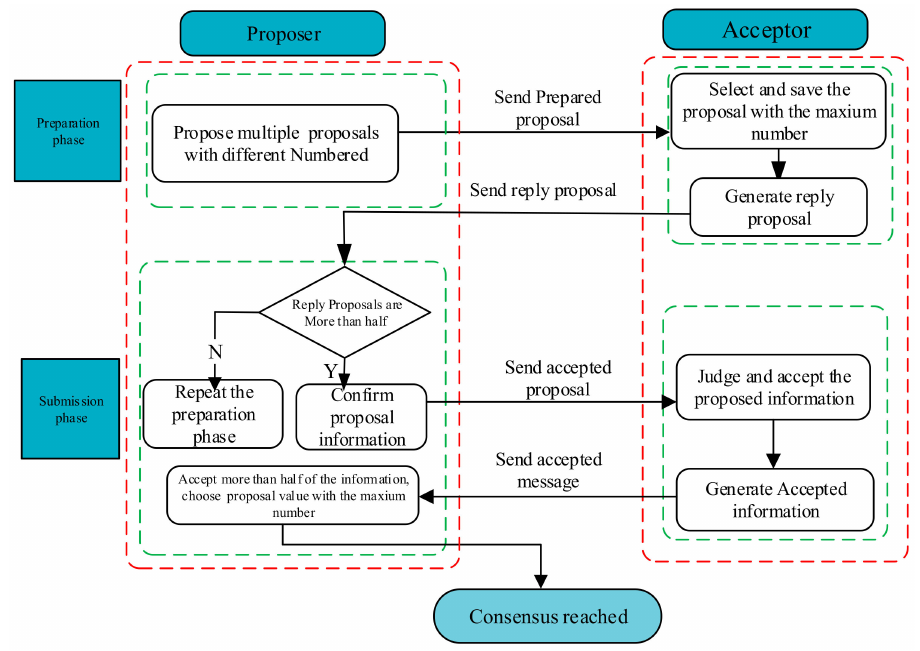
Figure 3. Paxos algorithm